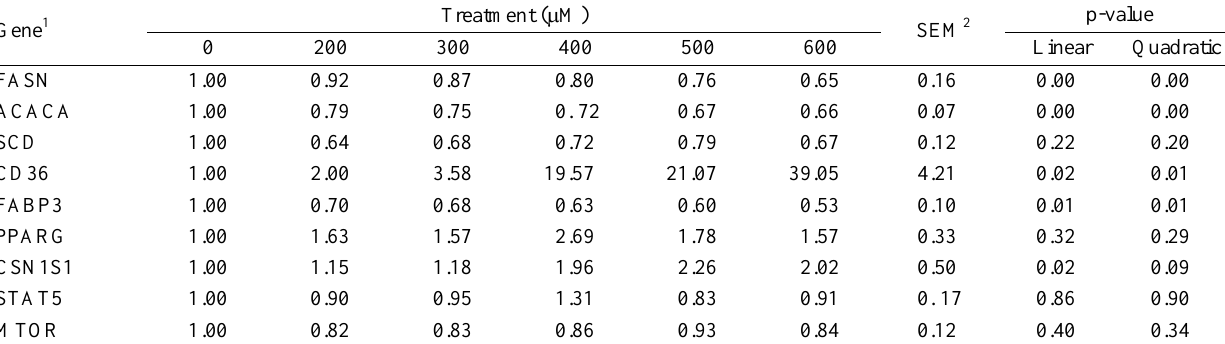
Table 4. Effect of palmitate on the mRNA expression of genes involved in lipid synthesis in BMECs Gene 1